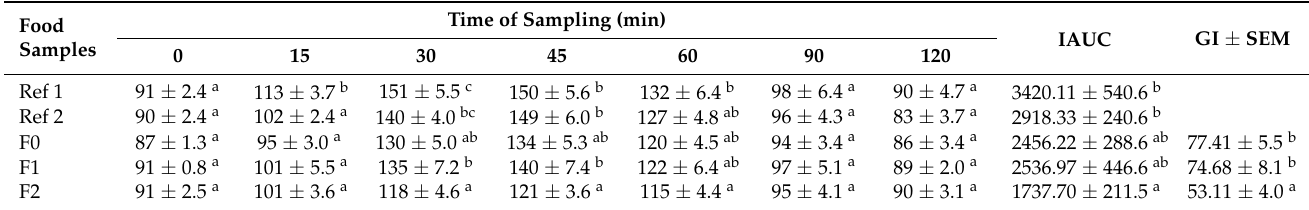
Table 4. Glycemic index (GI ± SEM) of extruded purple sweet potato and kidney bean.